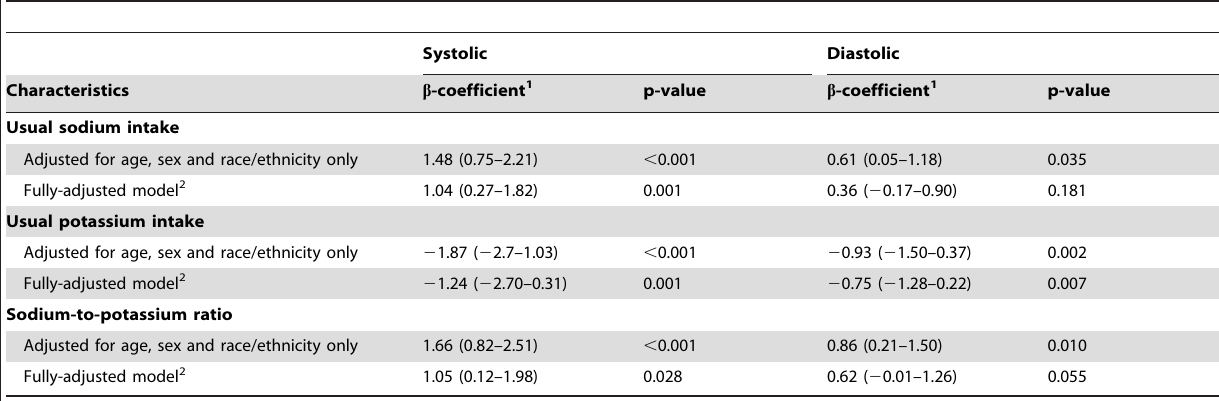
Table 3. Association between usual intake of sodium, potassium and their ratio and blood pressure among adults aged $ 20 years who were not taking antihypertensive medication, NHANES